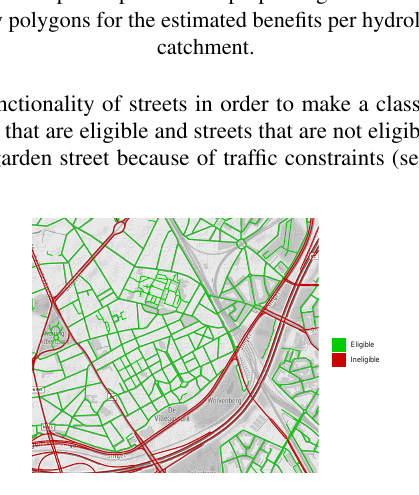
Figure 8. The Antwerp dashboard should include information about the mobility function of streets because only local streets are eligible for transformation to garden